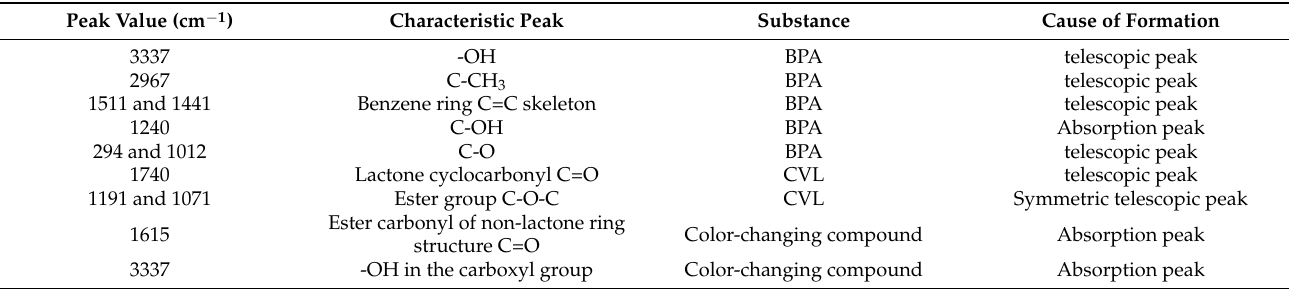
Table 7. Characteristic peaks of the infrared